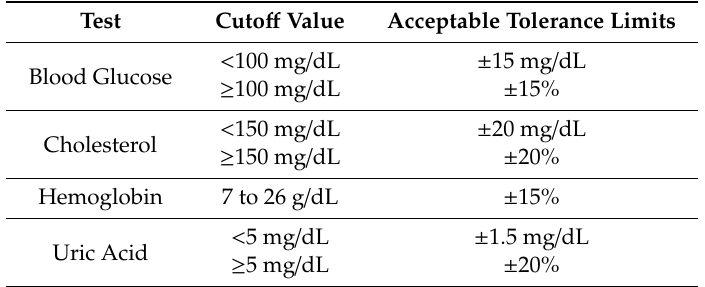
Table 2. Tolerance limits for blood glucose, cholesterol, hemoglobin and uric acid.